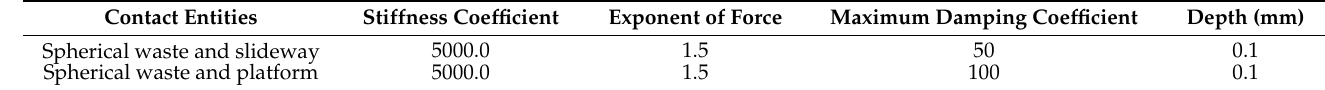
Table 4. Parameter values of the impact function.